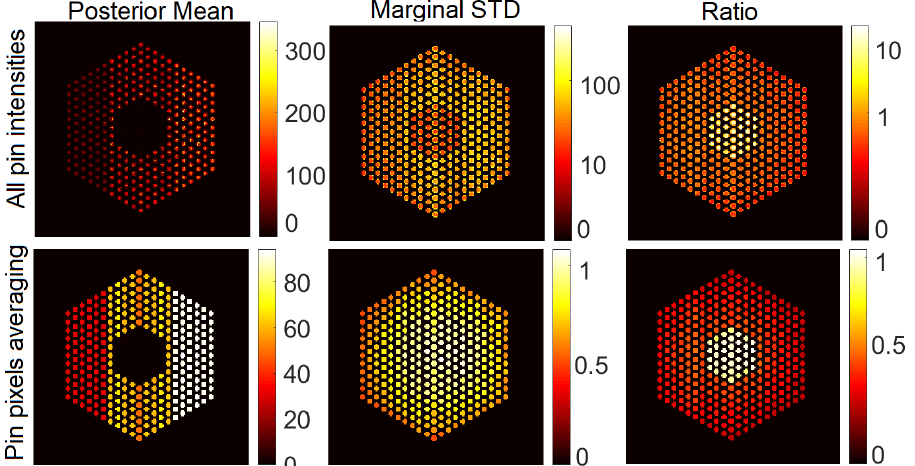
Figure 7. Pin activity estimation using SPA-P- (cid:96) 1 , using the Poisson noise model when peak value is set to 220. The results using the Gaussian noise model (SPA-G- (cid:96) 1 ) using peak value = 220 and noise variance σ 2 = 2 × 10 − 3 present similar trends and hence are not presented here.